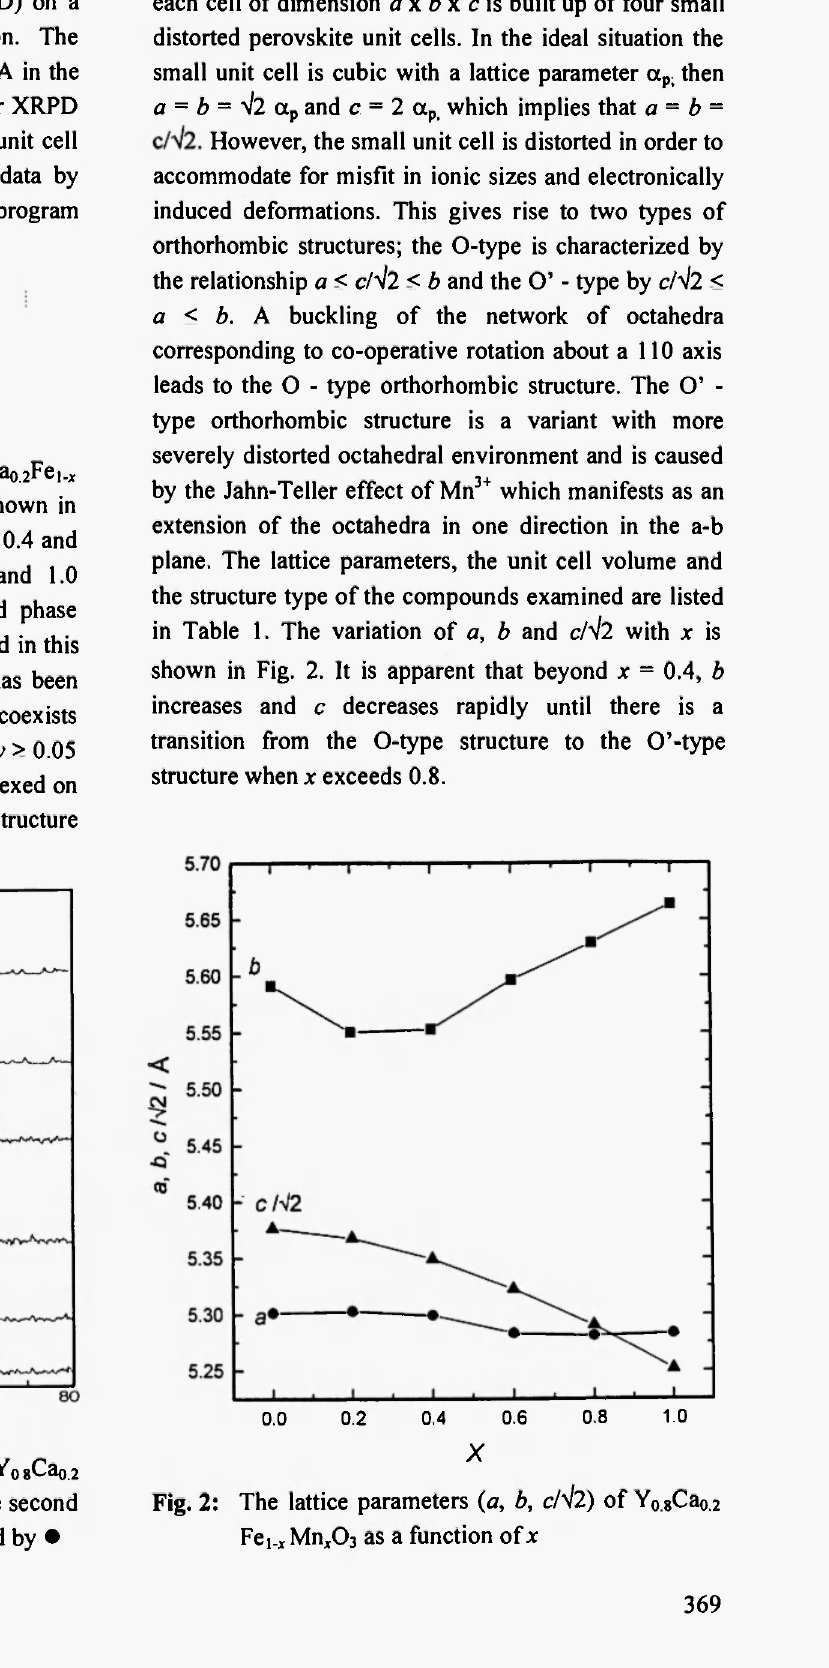
Fig. 1 : X-ray powder diffraction patterns of Y og Cao.2 Fe,.* Μη*0 3 . Peaks corresponding to the second phase (hexagonal YMn0 3 ) are identified by ·